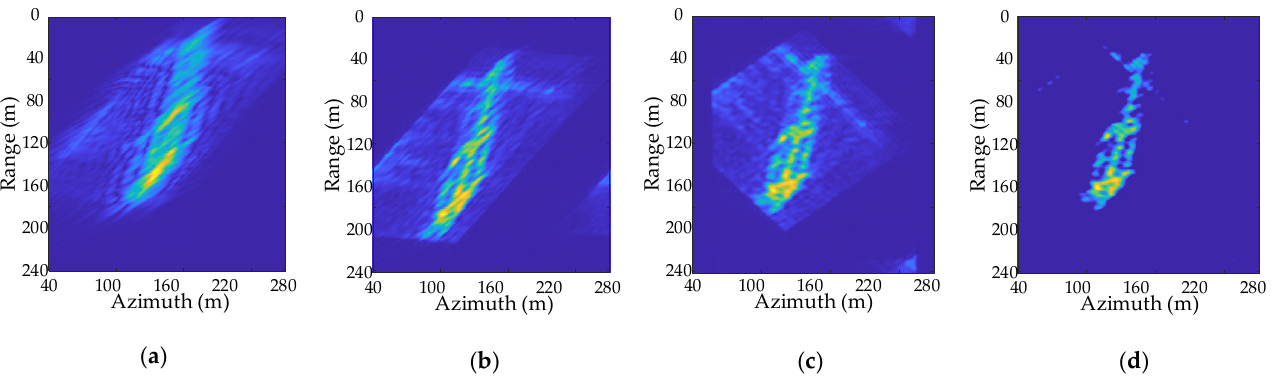
Figure 14. Ship target refocusing process in Squint-looking SAR: ( a ) Defocused ROI image; ( b ) Focused image without spectrum rotation; ( c ) Focused image with ESASR; ( d ) Image of sparse enhancement.